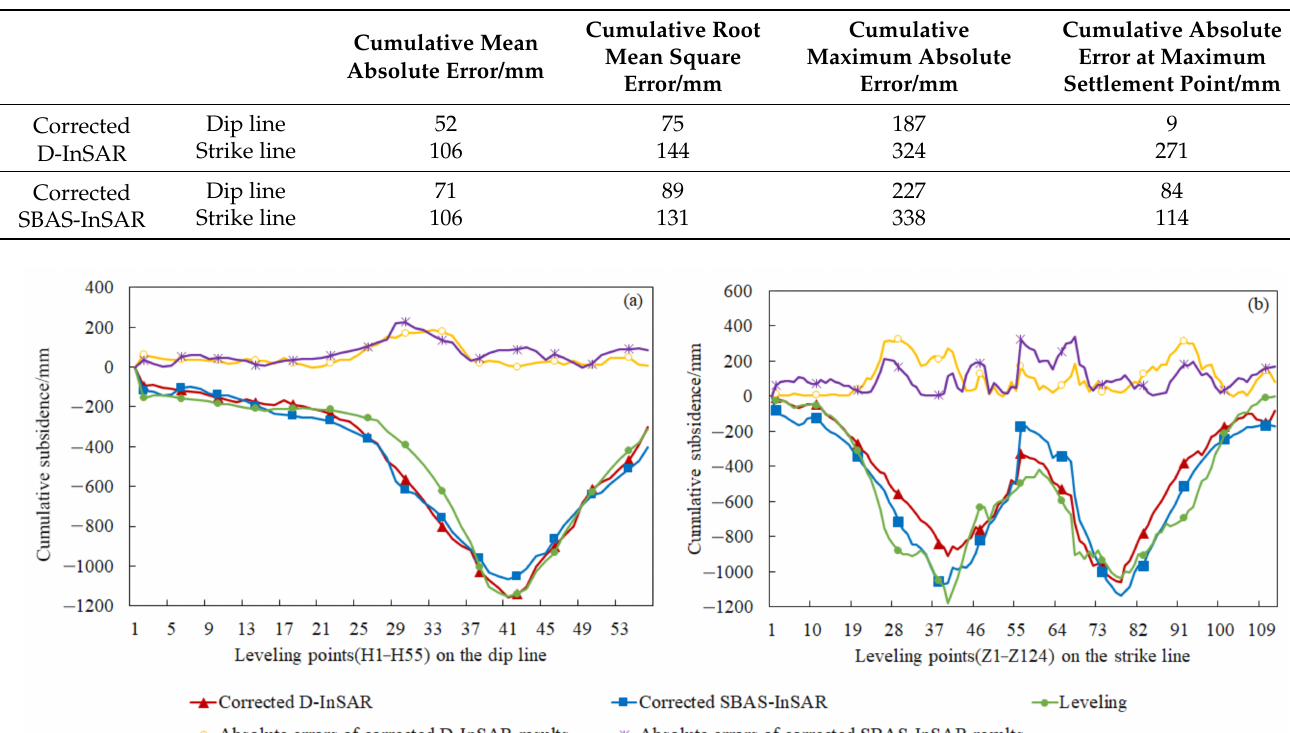
Table 4. Error statistics of corrected InSAR-monitored results.